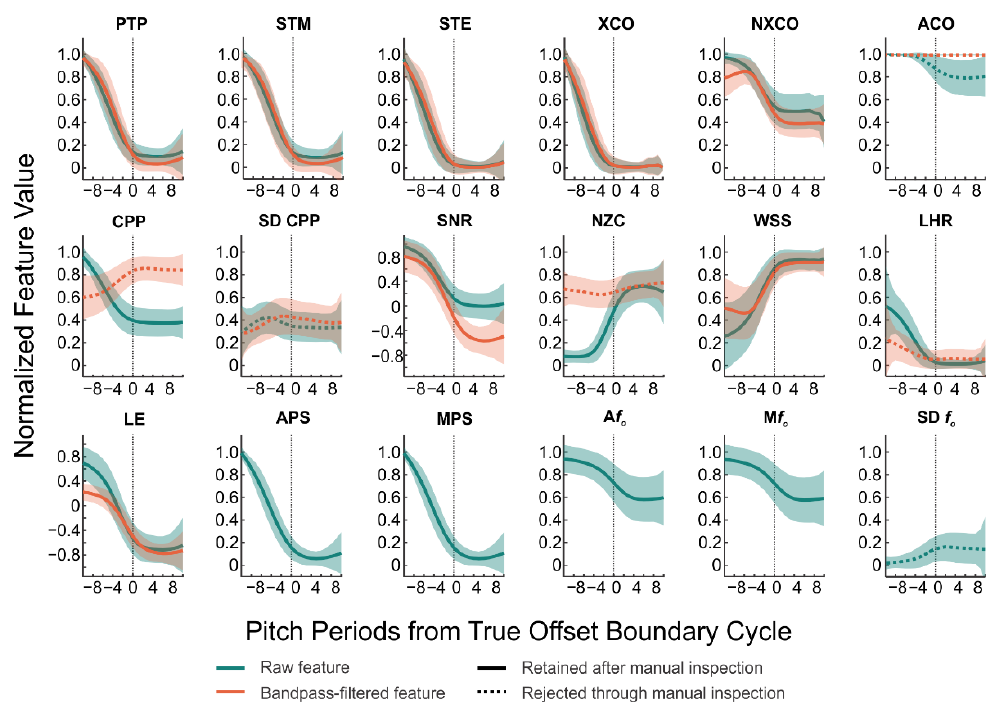
Figure 3. Normalized feature values calculated from the raw microphone signal or Auditory-SWIPE ′ output (teal) with respect to distance (pitch periods) from the true boundary cycle (thin black dotted line) for voicing offset. Normalized feature values calculated from band-pass filtered microphone signal are overlaid in orange (when applicable). Top row: normalized peak-to-peak amplitude (PTP), short-time magnitude (STM), short-time energy (STE), cross-correlation (XCO), normalized cross-correlation (NXCO), autocorrelation (ACO). Middle row: mean and standard deviation of cepstral peak prominence (CPP, SD CPP), signal-to-noise ratio (SNR), number of zero crossings (NZC), waveform shape similarity (WSS), low-to-high ratio of spectral energy (LHR). Bottom row: log energy (LE), average and median pitch strength (APS, MPS), average, median, and standard deviation of f o (A f o , M f o , SD f o ). Thick solid lines indicate mean values of features that were retained after manual inspection. Thick orange and teal dashed lines indicate mean values of features that were removed through manual inspection. Shaded regions indicate standard deviation.